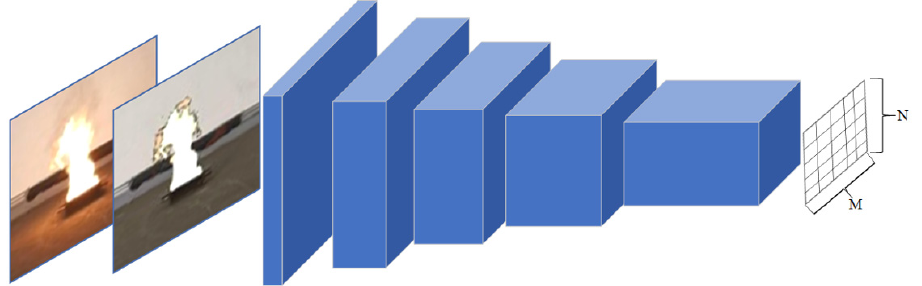
Figure 7. The local discriminator module structure.